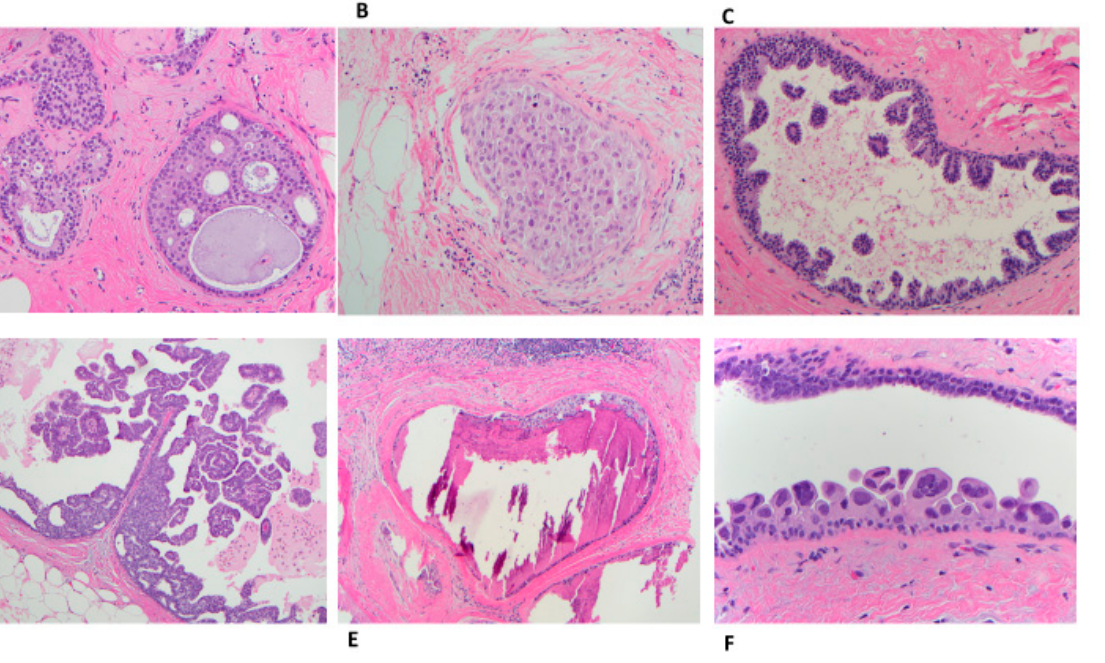
Figure 4. Ductal carcinoma in situ patterns; ( A ) cribriform with “cookie-cut” fenestrations (H&E 10×); ( B ) Solid (H&E 20×); ( C ) Micropapillary with club-shaped growth pattern (H&E 10×); ( D ) Pa- ( B ) Solid (H&E 20 × ); ( C ) Micropapillary with club-shaped growth pattern (H&E 10 × ); ( D ) Papillary pillary with fibrovascular core (H&E 10×); ( E ) Comedo with extensive intraductal expansile dirty with fibrovascular core (H&E 10 × ); ( E ) Comedo with extensive intraductal expansile dirty necrosis necrosis and surrounding fibrosis and lymphocytes (H&E 10×); ( F ) clinging (flat) with disorderly and surrounding fibrosis and lymphocytes (H&E 10 × ); ( F ) clinging (flat) with disorderly arrange arrange high grade cells (H&E 40×). high grade cells (H&E 40 ×